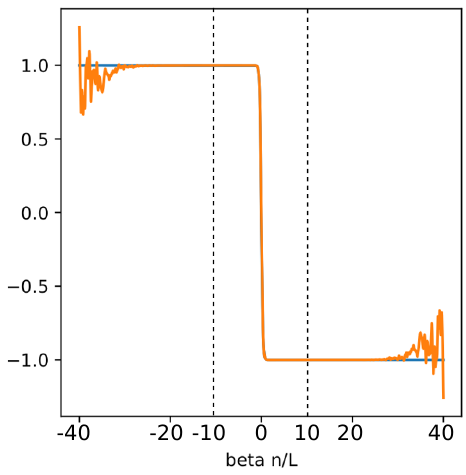
Figure 15 . (Orange) The left hand side of eq. (3.20) for β = 80 , dt = 0 . 2 . The Green function is defined on a strip of width L = 1600 . (Blue) tanh function. We expect that they should match for frequencies much less than the inverse discretization timestep: n/L (cid:28) 1 /dt . In on this graph this UV cutoff is at βn 400 . The region used for the fit, β | n | /L ≤ 10 , is within the dashed max /L ∼